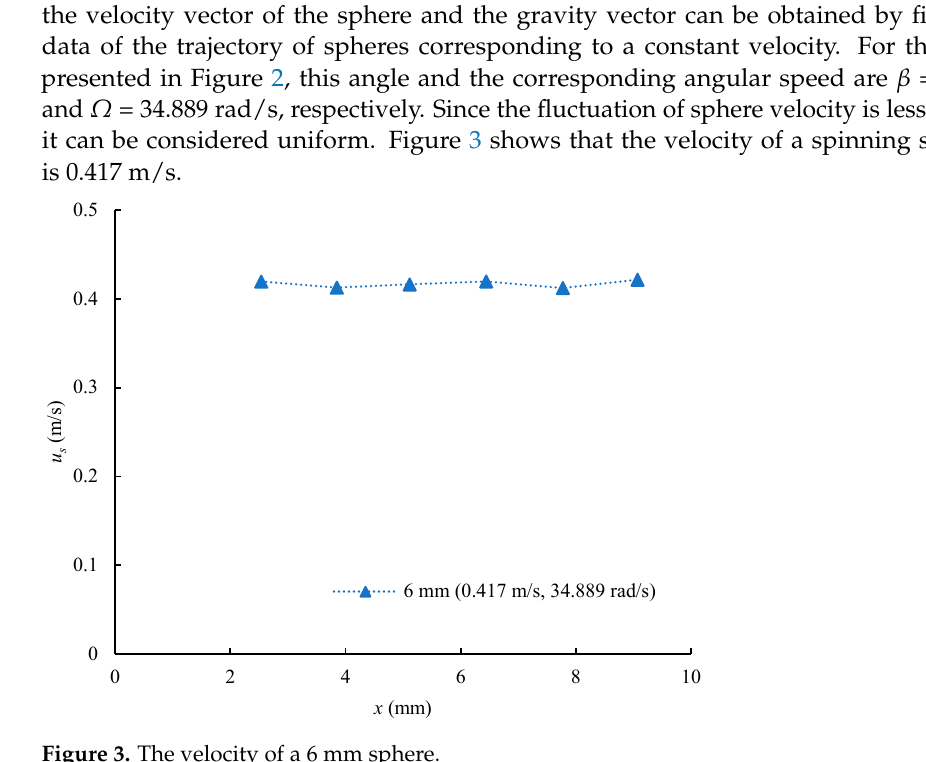
Figure 3. The velocity of a 6 mm sphere.